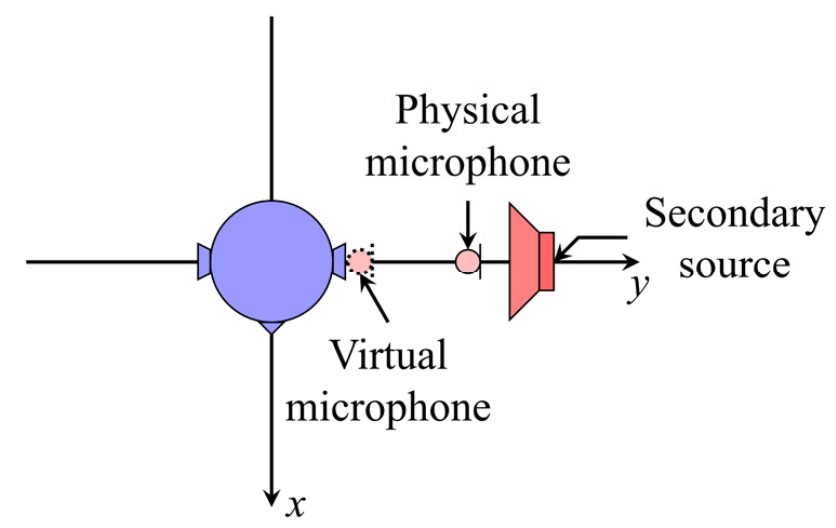
Figure 3. Single channel active headrest system (Top view). As for an active headrest system with four secondary sources, two different layouts are discussed as shown in Figure 4. Again, due to the weak coupling effects of the trans- mission channels of the secondary sources on either side of the human head, only the dual-channel system on the left side of the head is considered. The physical system of layout A is symmetrical about the y -axis in the xy -plane, with two secondary sources on each side of the head and corresponding physical microphones near each secondary source. The y coordinates of secondary sources and physical microphones are ±30 cm and ±18 cm respectively, while each secondary source, its corresponding physical microphone and the origin are aligned on the same line, which has an angle α of 30° with the y -axis. The evaluation points are located at the midpoint of the two virtual microphones spaced 2 cm apart, as in the single channel control system, which are on the y -axis and 2 cm from the surface of the rigid sphere. For layout B, the virtual microphone positions remain the same, and the relative positions of the secondary sources and physical microphones to the rigid sphere are the same as in layout A, except that they are arranged in the yz- plane.